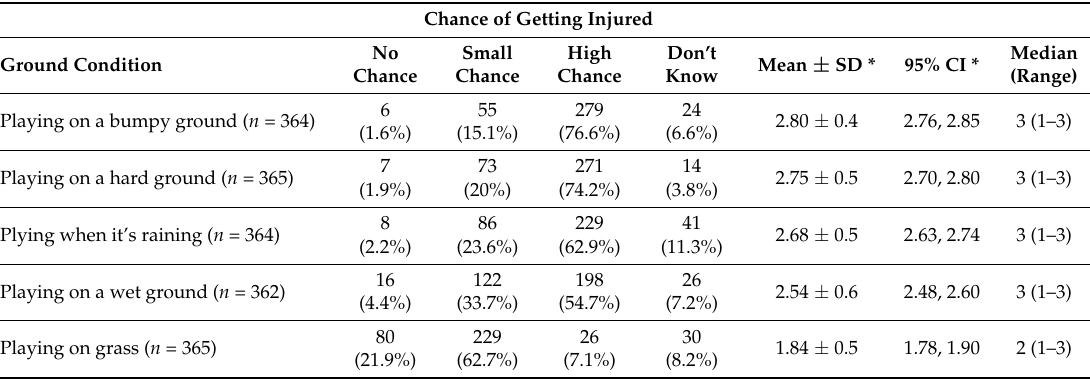
Table 3. Frequency and percentage (%) of perceived injury risk when playing in different ground conditions, and mean of risk with 95% confidence interval